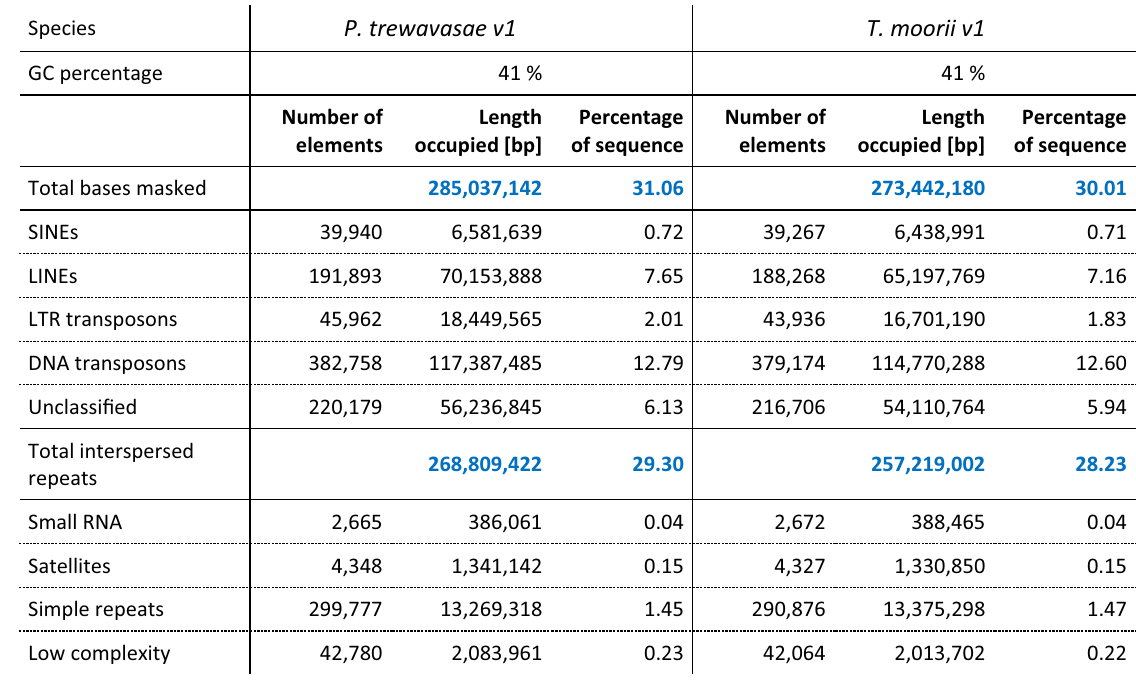
Table 4. Repeat annotation statistics as determined by RepeatMasker 32